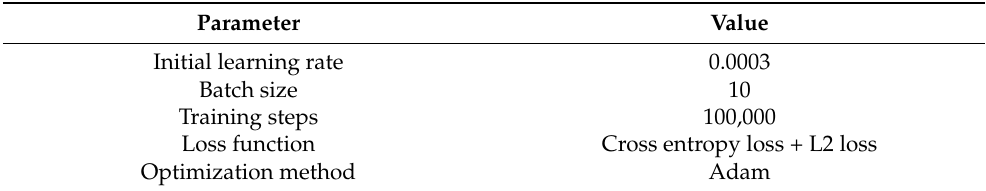
Table 1. Model hyperparameter